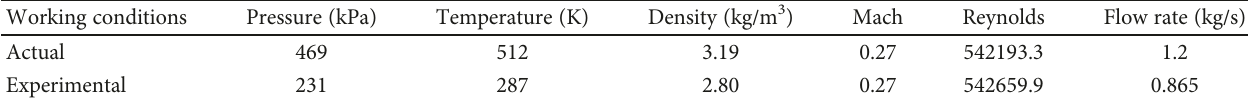
Figure 7: The outer and inner bleeding hole. Table 5: Experimental fl ow